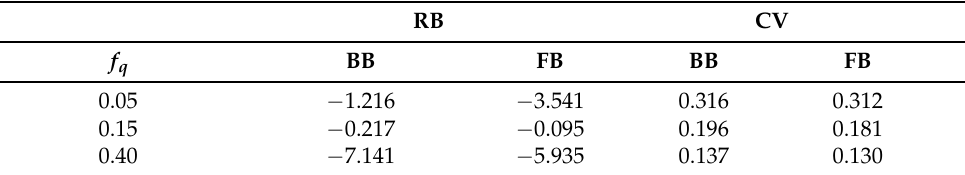
Table 3. Performance indicators for DGP 1 considering p = 0.6.